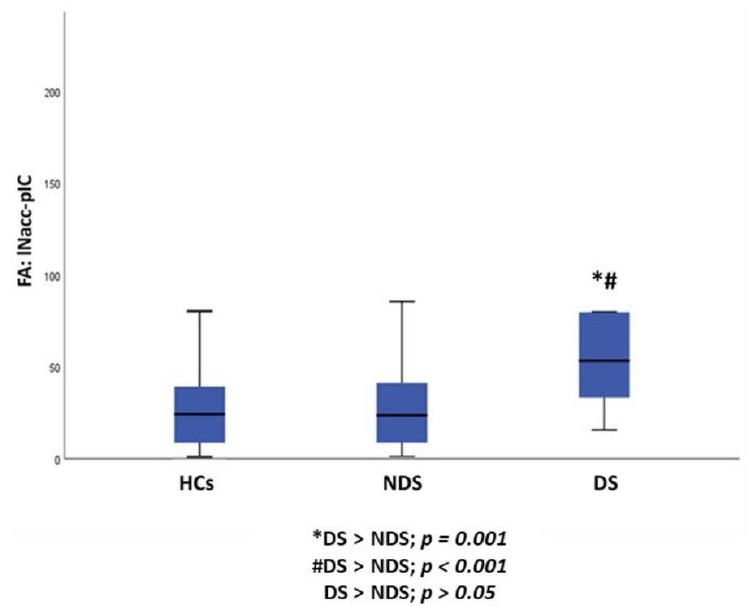
(Table 3, Figure 3).